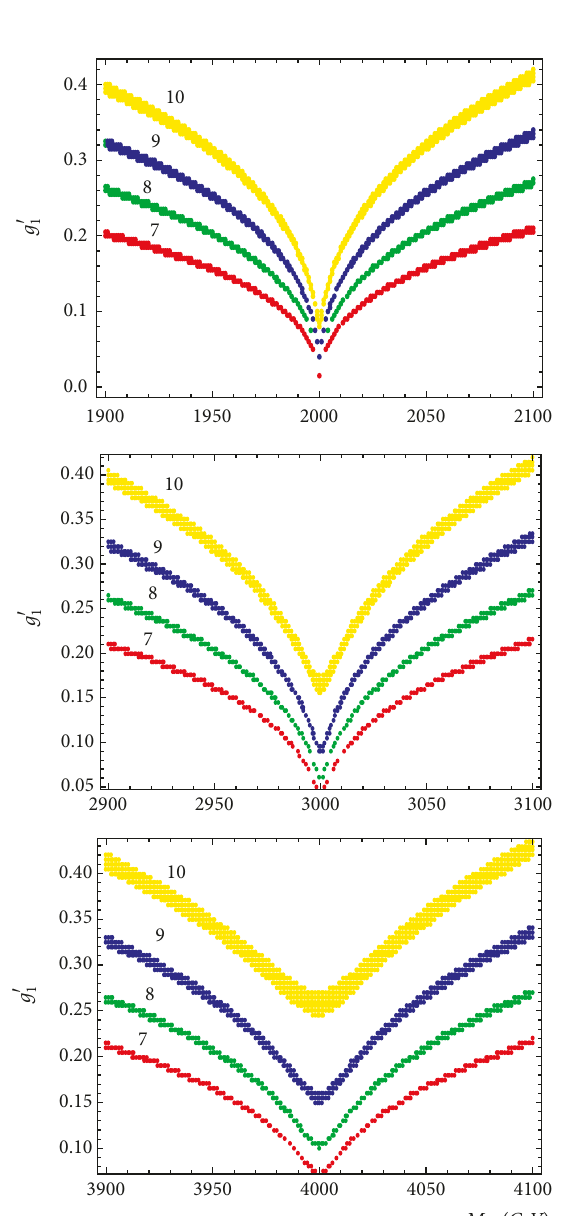
Figure 5: Correlation between 𝑀 푍 󸀠 and 𝑔 耠 1 . Top panel: the contours correspond to 𝜎 푇표푡 = 7, 8,9,10𝑓𝑏 and √𝑠 = 2000 𝐺𝑒𝑉 . For the central panel, the contours hold for 𝜎 푇표푡 = 7, 8, 9,10 𝑓𝑏 and √𝑠 = 3000 𝐺𝑒𝑉 and for the bottom panel 𝜎 = 7, 8,9,10 𝑓𝑏 and √𝑠 = 푇표푡 4000 𝐺𝑒𝑉 .